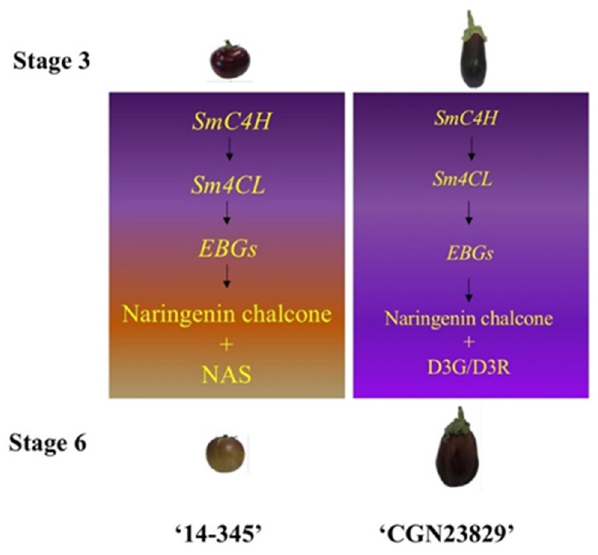
Figure 5. Proposed model underlying the fruit color changes in ‘14-345’ and ‘CGN23829’. The font size of ‘SmC4H’, ‘Sm4CL’ and ‘EBGs’ corresponds to the expression levels. The font size of ‘Naringenin chalcone’, ‘NAS’ and ‘D3G/D3R’ indicates the contents. Flavonoid biosynthesis is mainly regulated by two types of genes; one is the structural gene, including EBG and LBG, and the other is the transcription factor, including MYB, bHLH and WD40 [14,15]. CHS, CHI, F3H and F3’H are the EBGs that are directly regulated by MYBs [5,41]. F3 (cid:48) 5 (cid:48) H, DFR, ANS, AAT, 5GT and 3GT are the LBGs that control